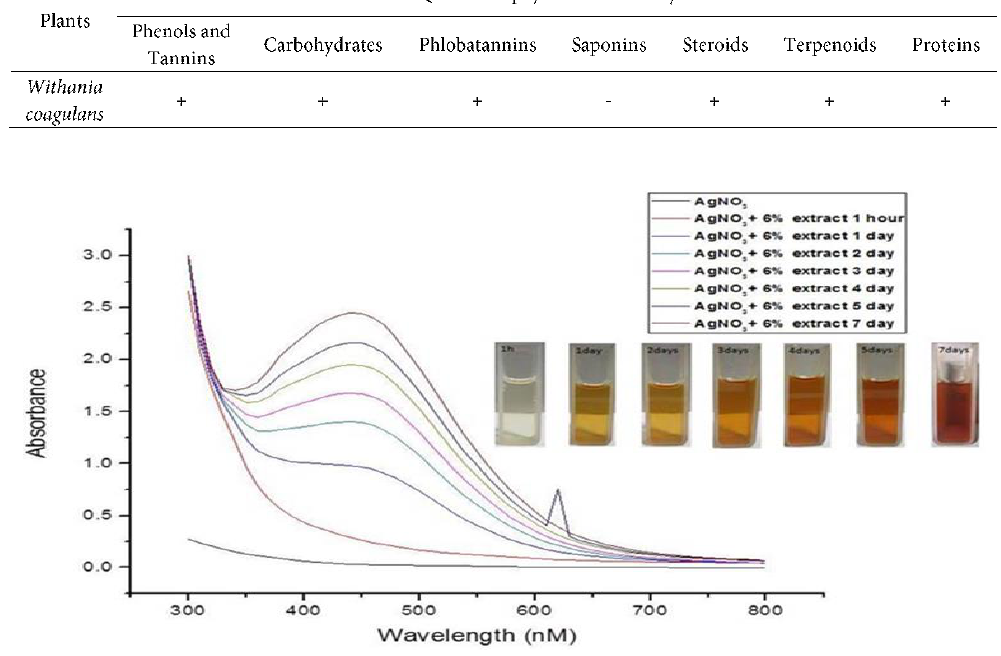
Fig. 1. The images represent the synthesis of silver Figure 1: The images represent the synthesis of silver nanoparticles